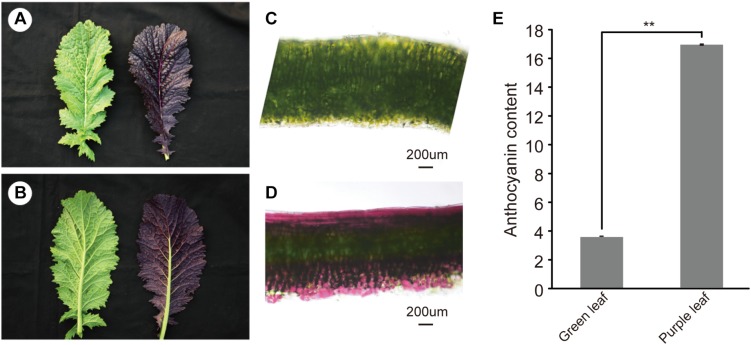
Morphology of purple leaf and anthocyanin content in B. juncea. (A) Upper epidermis of green (LvYi) and purple (ZiYi) leaf. (B) Lower epidermis of green and purple leaf. (C) Transverse section of a green leaf. Bars = 200 μm. (D) Transverse section of a purple leaf. Bars = 200 μm. (E) Total anthocyanin contents of green and purple leaves. **Signifcantly diferent at P < 0.01.